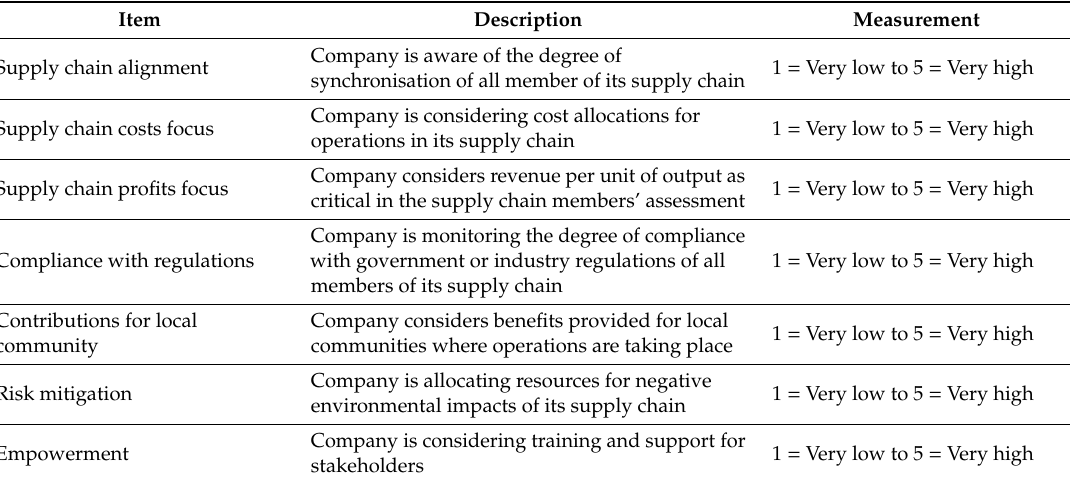
Table 6. Coordination items.